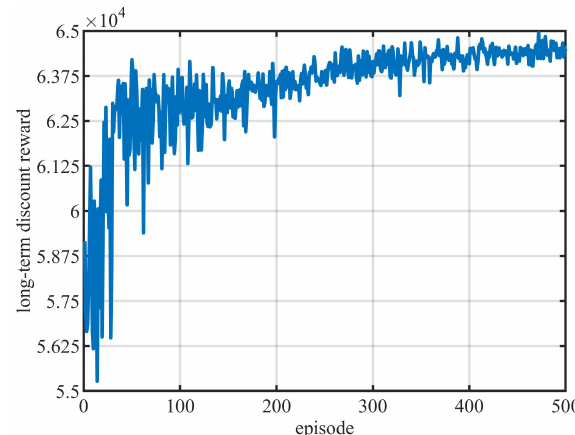
Figure 14. The curve of the long-term discount return with respect to the training episode in the door-opening task.